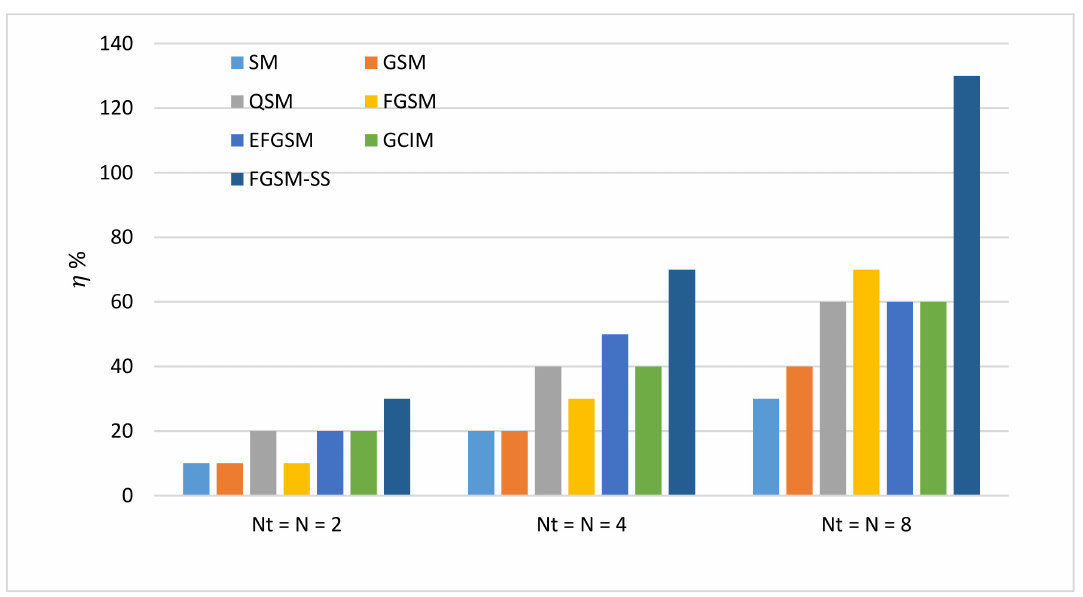
Figure 9. Performance comparison of energy e ffi